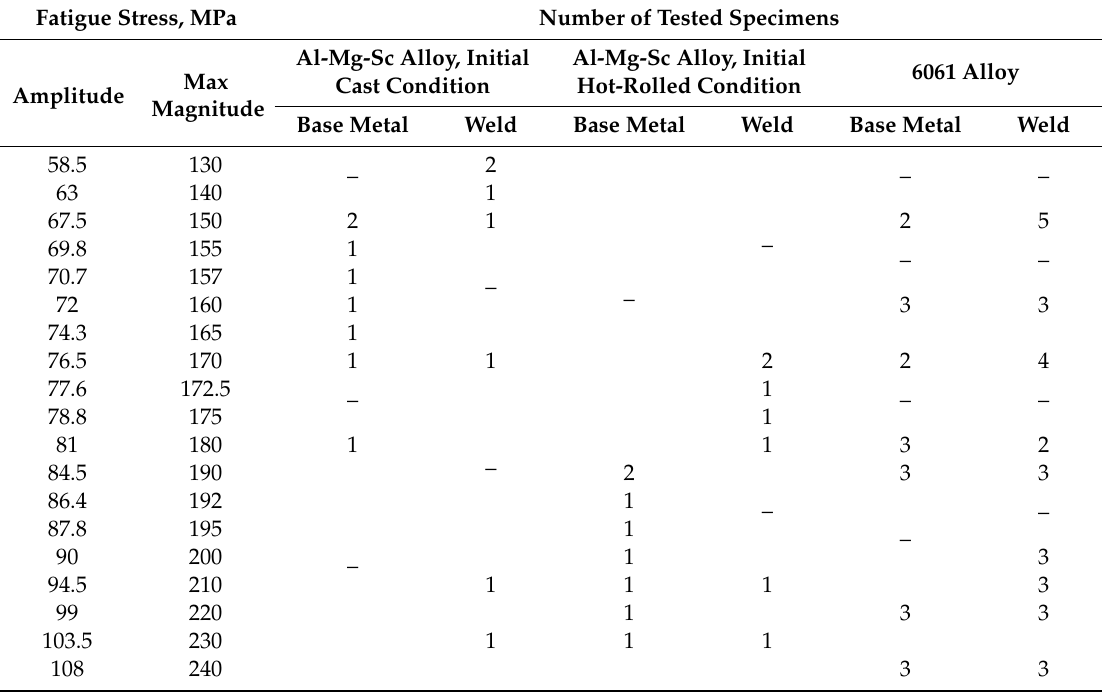
Table 2. Statistics of fatigue